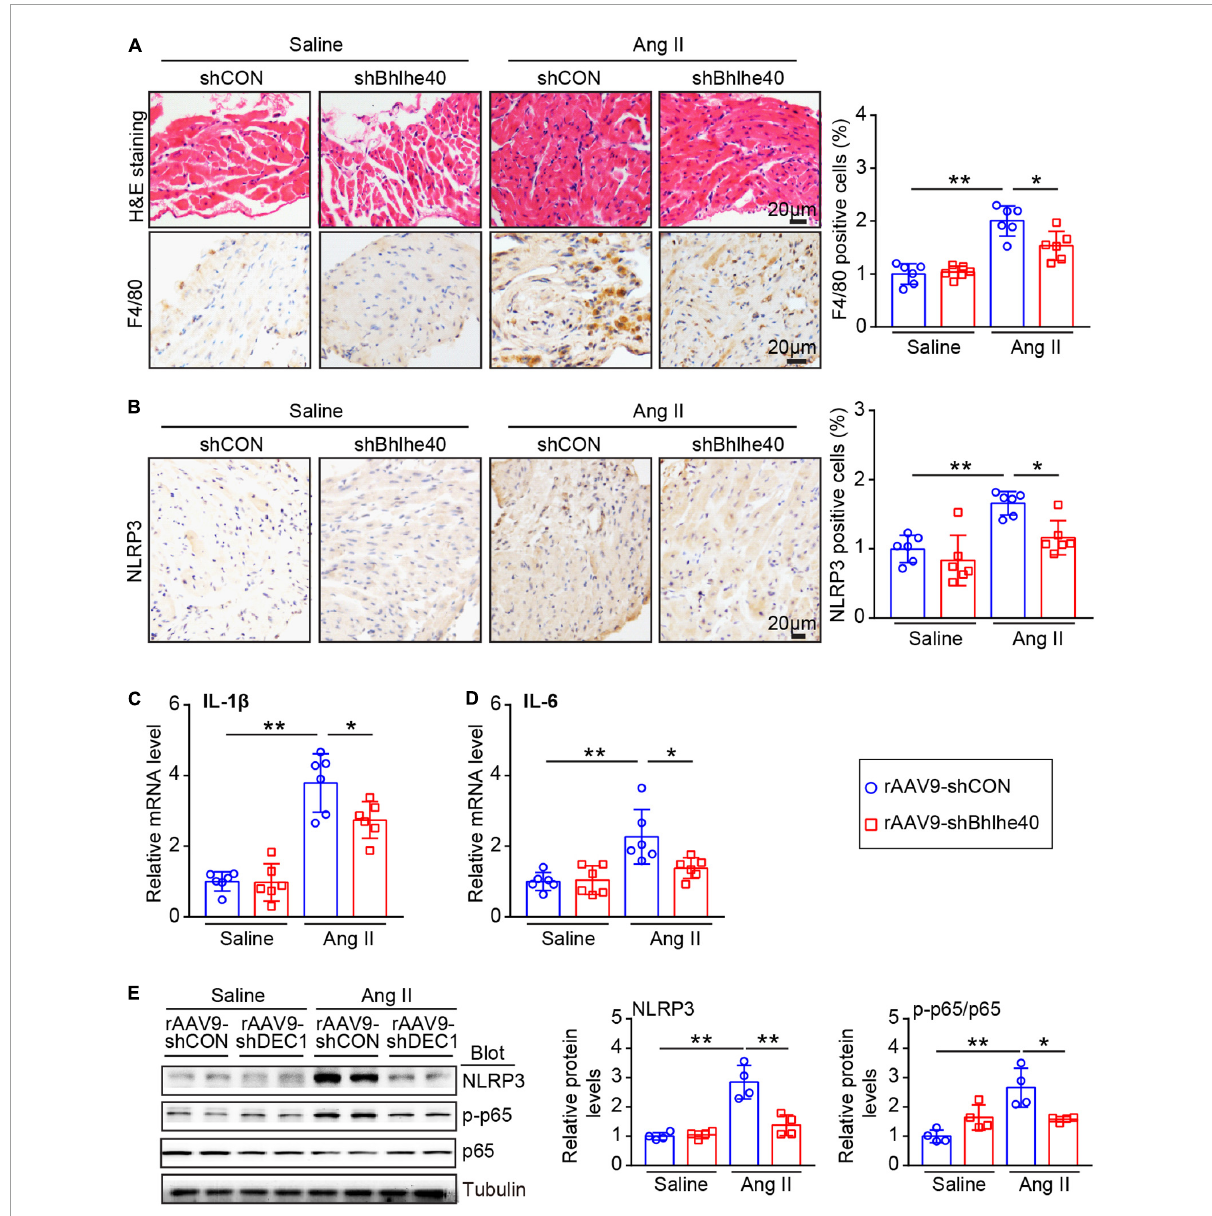
FIGURE6 Knockdown of Bhlhe40 by rAAV9-shBhlhe40 injection suppresses Ang II-induced atrial inflammation. (A) Representative hematoxylin–eosin (H&E) staining (top in left), IHC staining of F4/80 (bottom in left), and the quantification of F4/80-positive cells (right) from the IHC-stained sections from the rAAV9-shCON/rAAV9-shBhlhe40-treated and Ang II/saline-infused atrial tissues ( n = 6 mice per group). (B) Representative images of NLRP3 immunohistochemistry (left) and the quantification of NLRP3-positive cells (right; n = 6 mice per group). (C,D) qPCR analyses of pro-inflammatory cytokine levels (IL-1 β and IL-6) in atrial tissues ( n = 6). (E) Immunoblotting analyses (Left) and quantification of ion channel subunits and connexin (Kv4.3and CX43) in atrial tissues ( n = 4). Tubulin served as an internal control. n indicates the number of animals. * P < 0.05 and ** P <